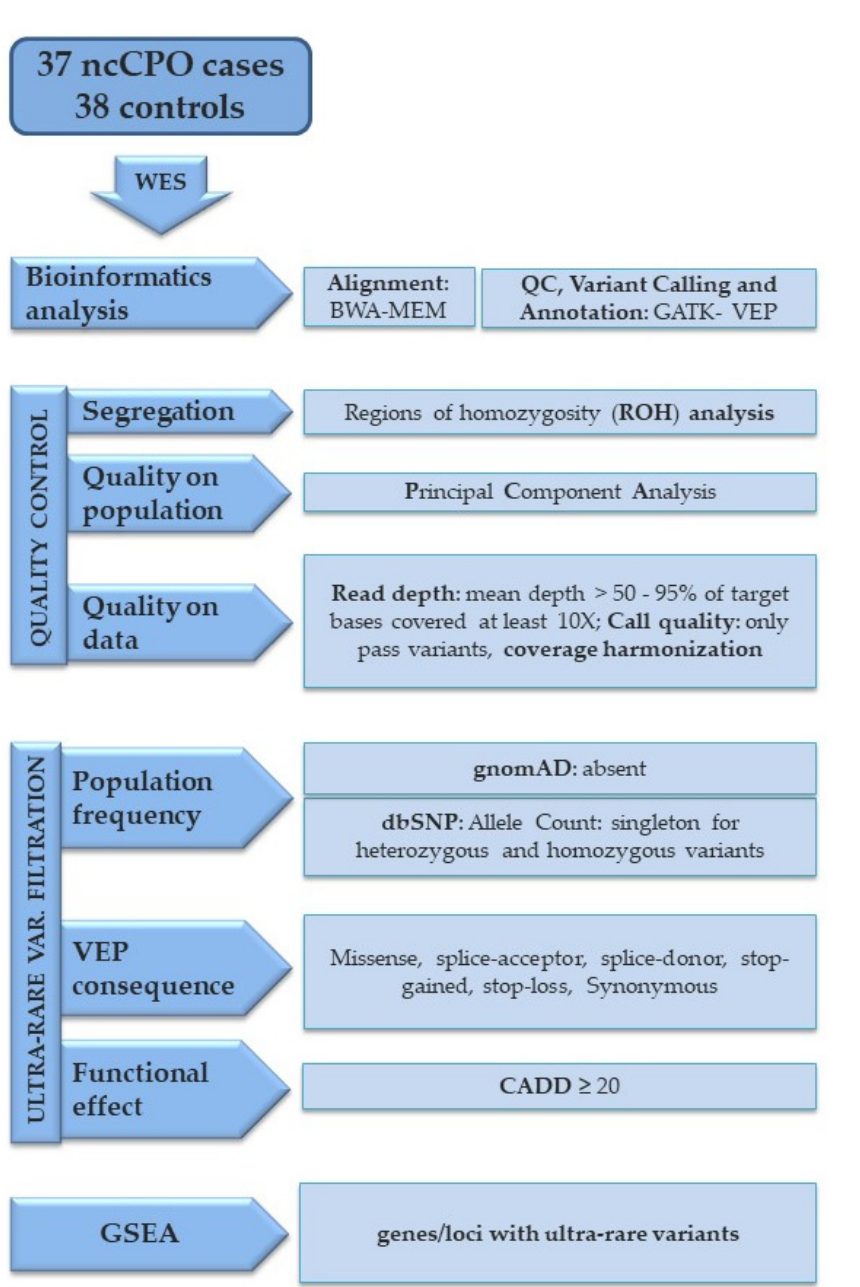
Figure 1. Flowchart of the analysis steps for generating gene lists with ultra-rare variants. The flowchart provides an overview of the approach used to select genes carrying ultra-rare variants from whole exome sequencing data for GSEA. Raw reads were aligned against hg19 reference genome using BWA MEM and, after duplicates were removed, SNVs were called using GATK. ROH analysis and PCA were performed as reported in the Methods section. Only the variants with a PASS filter were retained in the VCF file. Quality metrics were used to decide whether to include genes in downstream analysis; only genes with mean depth > 50× and 95% of target bases covered at least 10× were included. Moreover, genes with differences in coverage between cases and controls were excluded (see details for this in the Methods section). Variants predicted to be protein-altering (missense, splice-acceptor, splice-donor, stop-gained, stop-loss) were aggregated. Synonymous variants were only used in GSEA as a comparison group of variants, as they are not as likely to be implicated in nsCPO. Population frequency filter and functional effect predictor score were applied as described in the Methods section.